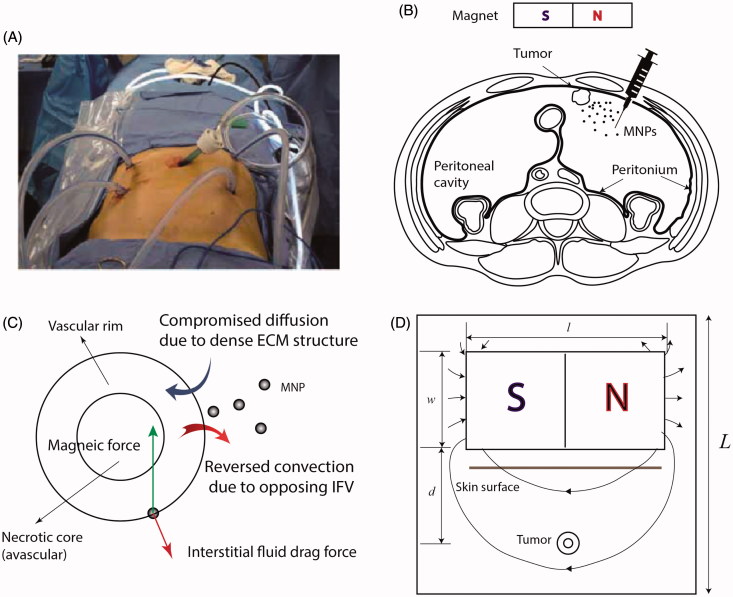
IP chemotherapy. (A) Clinical application of intraperitoneal (IP) chemotherapy (Wademan et al., 2012) (B) Schematic of the proposed magnetically assisted IP chemotherapy. Horizontal disposition of the peritoneum targeted with drug-loaded magnetic nanoparticles (MNPs). A permanent external magnet is utilized to impel MNPs across tumor nodules and surpass interstitial barriers. (C) Pathophysiology of tumors gives rise to opposing convective flows of the interstitial fluid at the tumor periphery which repel MNPs. Moreover, desmoplasia tends to hinder diffusive transport of MNPs. Magnetic forces can be applied to counteract these effects. (D) The geometry corresponding to the model of magnetically assisted IP drug delivery.